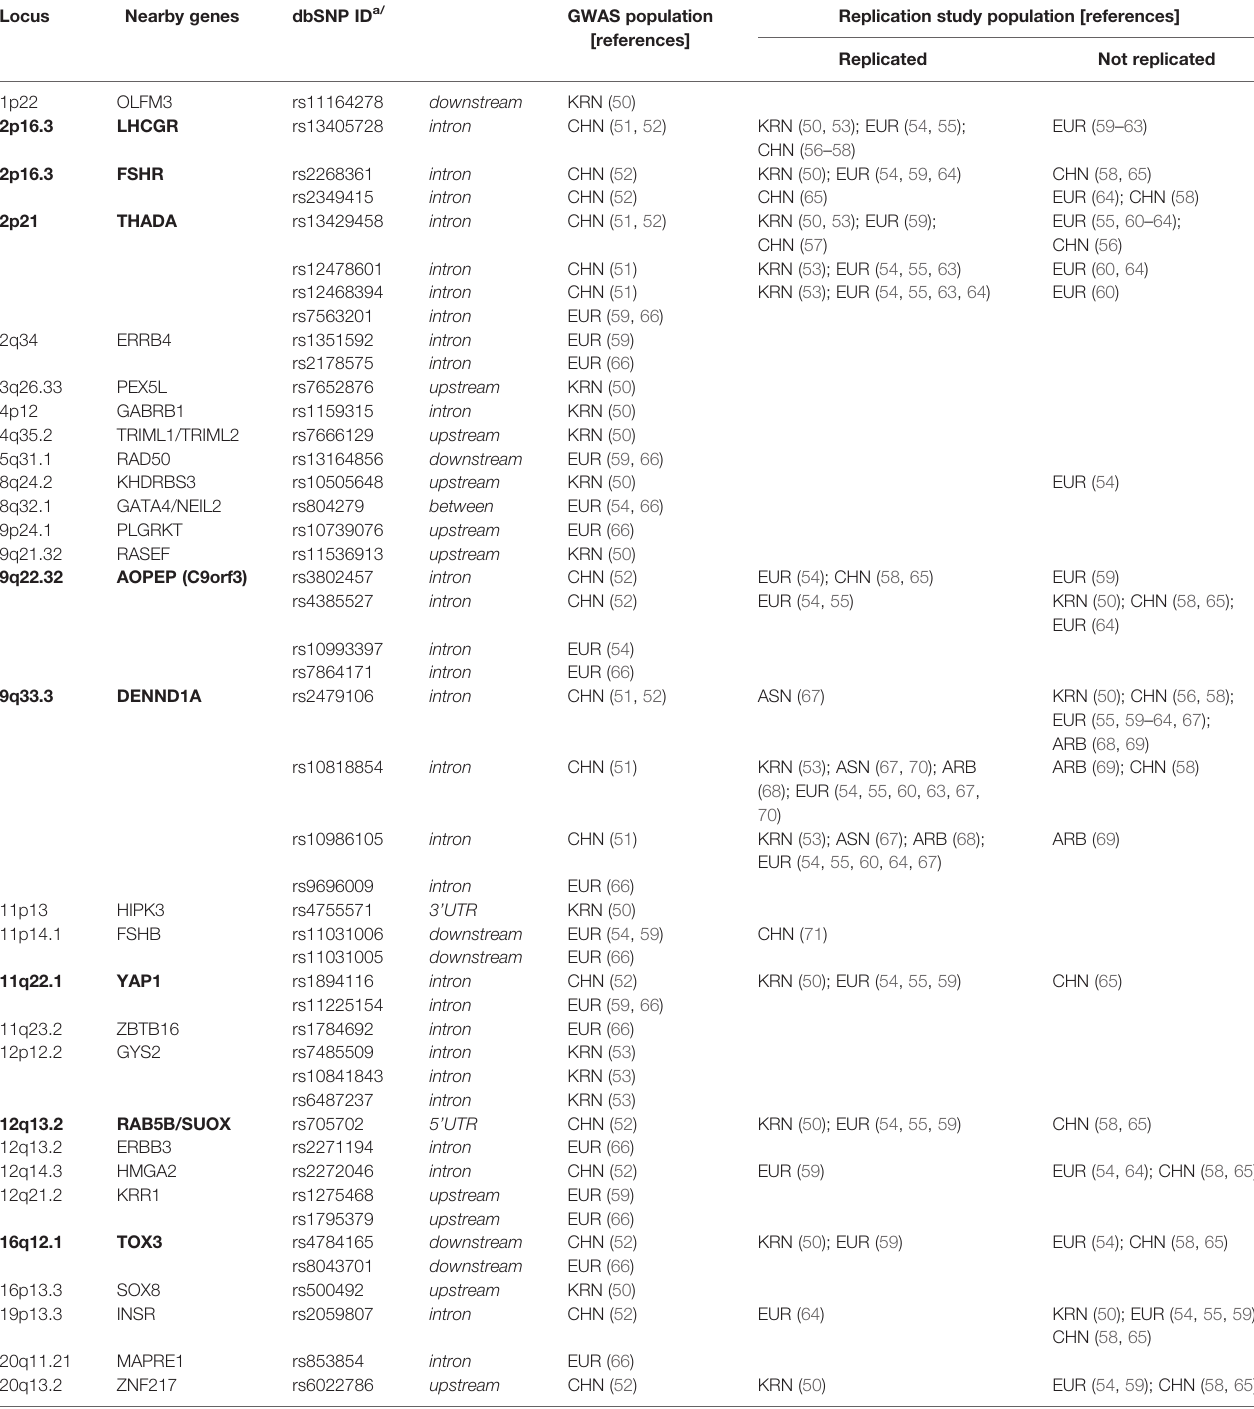
TABLE 1 | GWAS and replication studies for PCOS susceptibility.